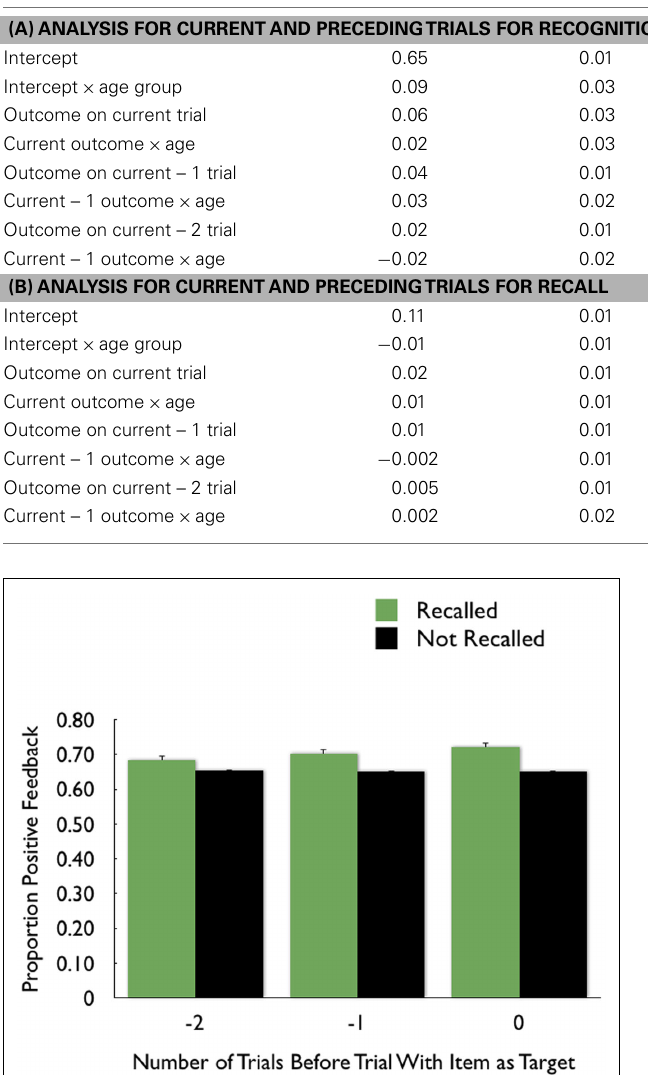
FIGURE 6 |The proportion of recalled pictures compared with forgotten pictures that had been preceded by trials two back ( − 2) that had positive feedback; the proportion with positive feedback on the preceding trial ( − 1) and the proportion with positive feedback on the same trial